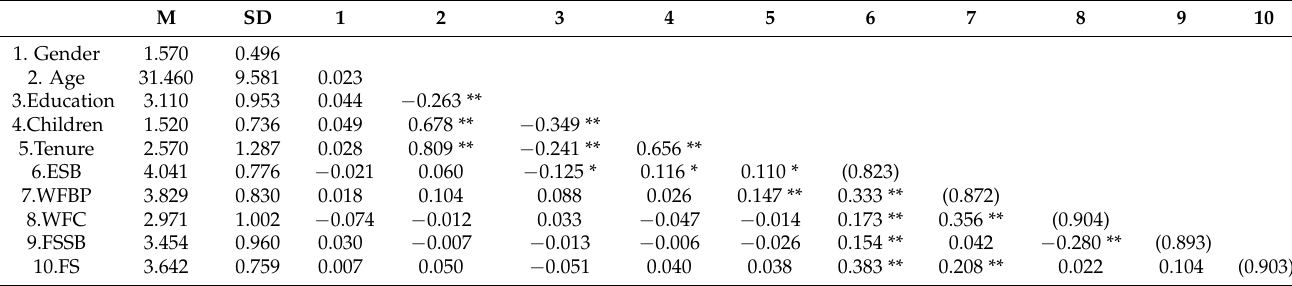
Table 1. Means, standard deviations, and